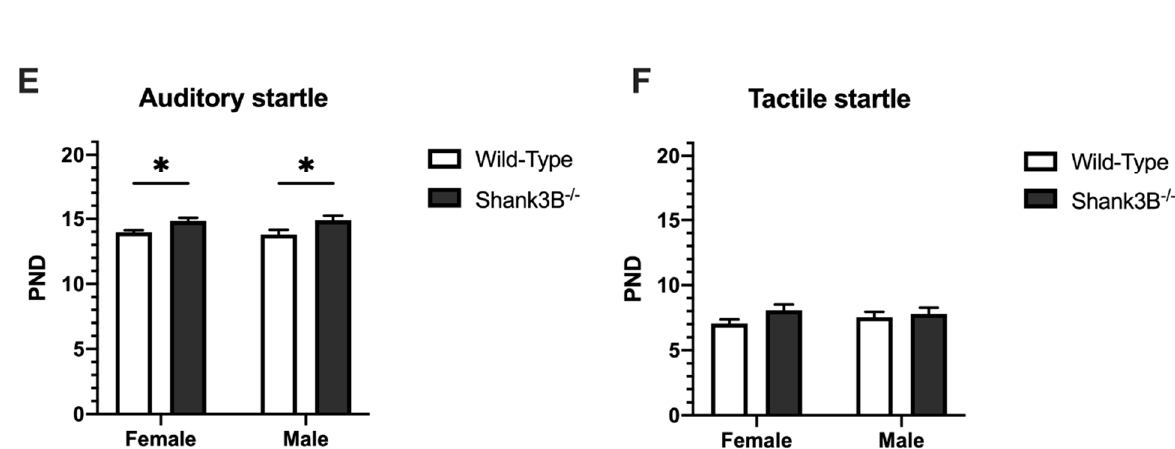
Figure 4. Reflexes. ( A ) Surface righting. ( B ) Air righting. ( C ) Forelimb grasp ( D ) Ear twitch reflex